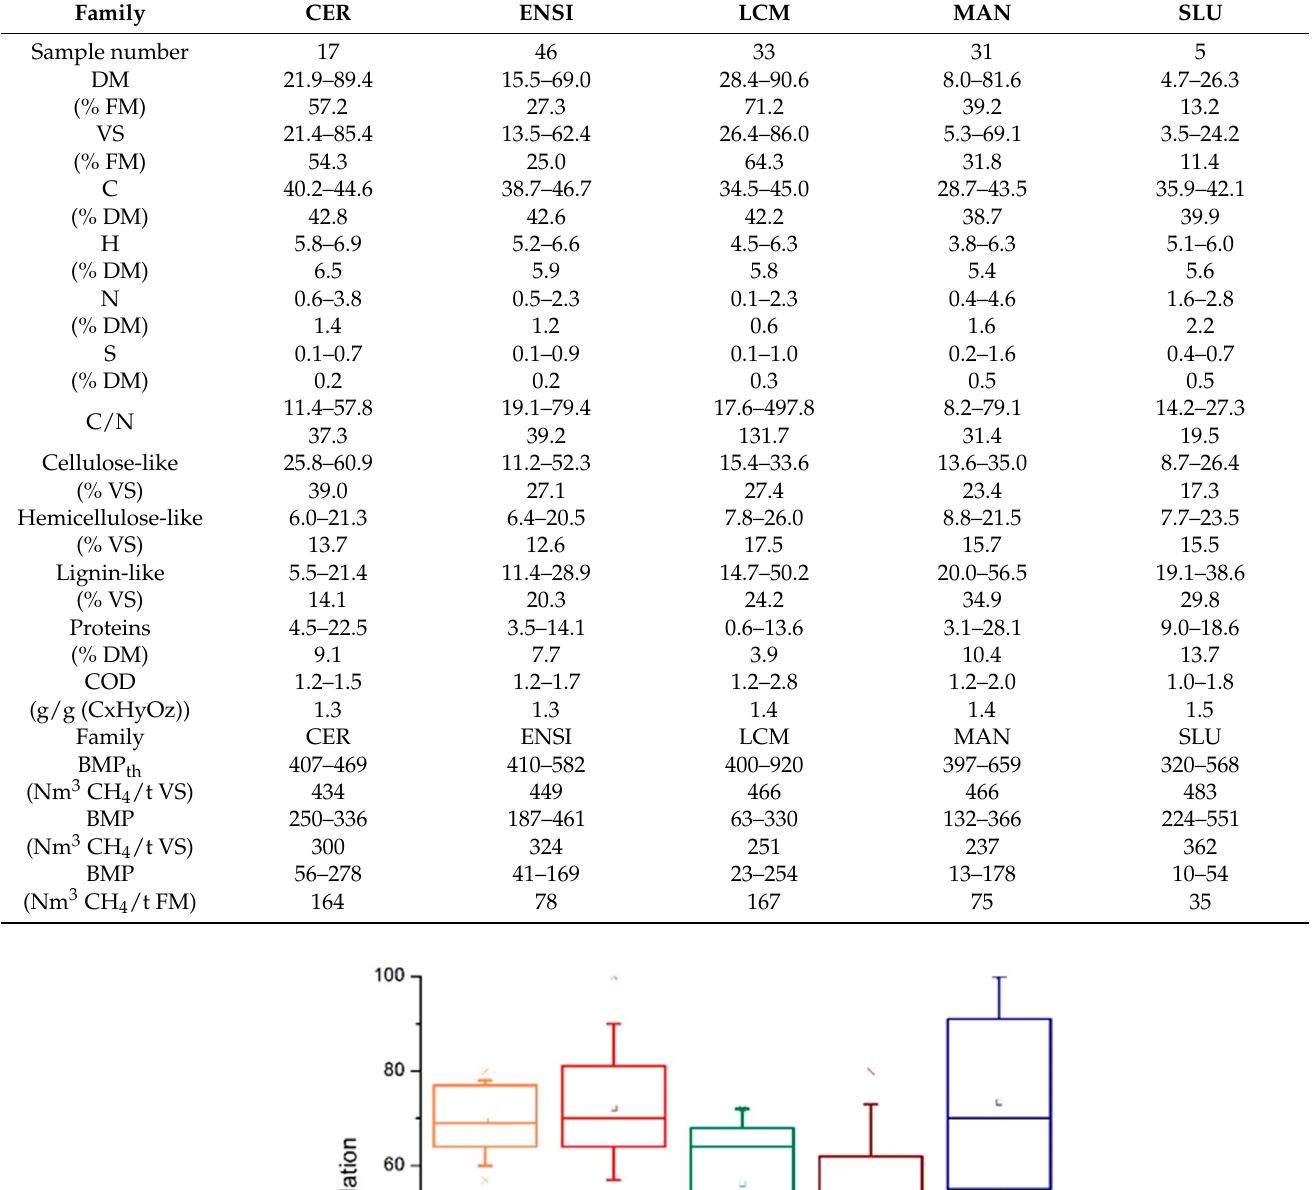
Table 2. Chemical composition of the families (FM: fresh matter; DM: dry matter; and VS: volatile solids). Families: cereals and residues (CER), energy crops and silage (ENSI), lignocellulosic matter (LCM), manures (MAN), and slurries (SLU).